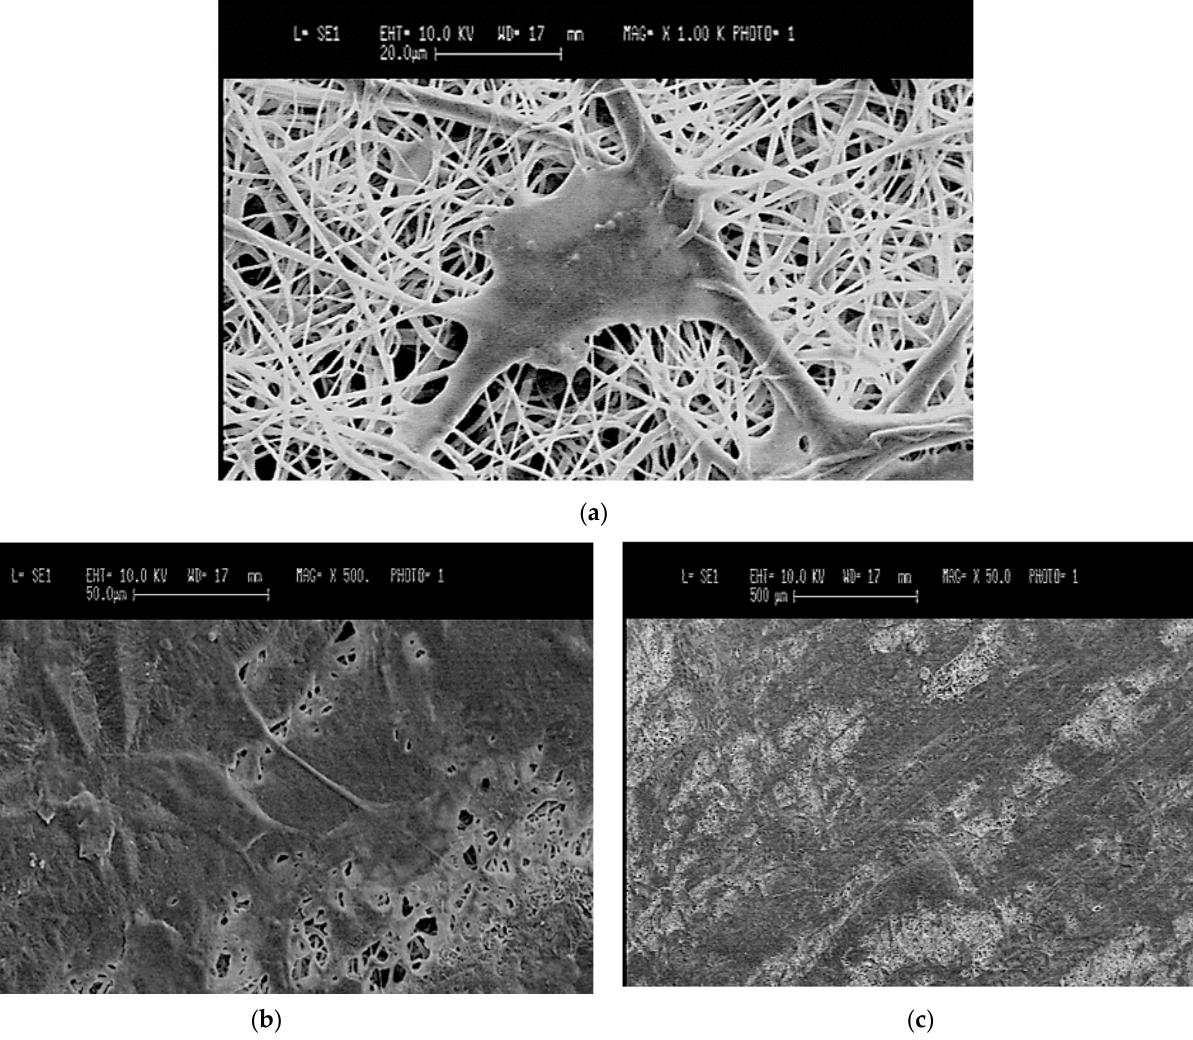
Figure 8. ( a ) SEM image of an ARPE-19 cell on BMSF/PCL scaffold 5 days after seeding (scale bar = 20 µm); ( b ) SEM image of ARPE-19 cells on BMSF/PCL scaffold 5 days after seeding (scale bar = 50 µm); ( c ) SEM image of an ARPE-19 cell on BMSF/PCL scaffold 5 days after seeding (scale bar = 500 µm).